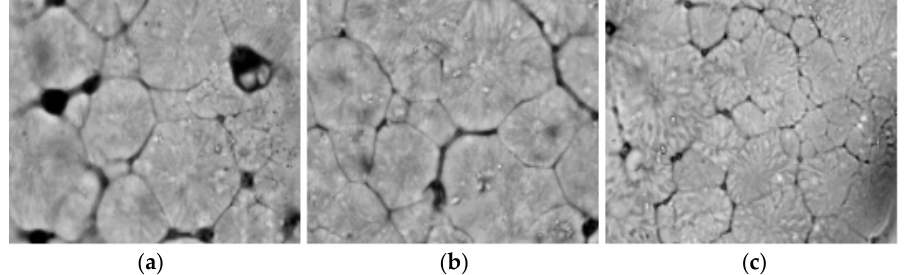
Figure 7. The polarizing microscope photographs of PLA/zeolite-4 ( a ), PLA/zeolite-6 ( b ) and PLA/zeolite-8 ( c ) amplified 1000 times.